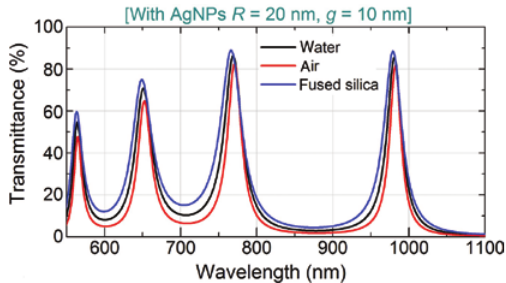
radius R = 10 nm when assembled on a 20-nm-thick Ag film